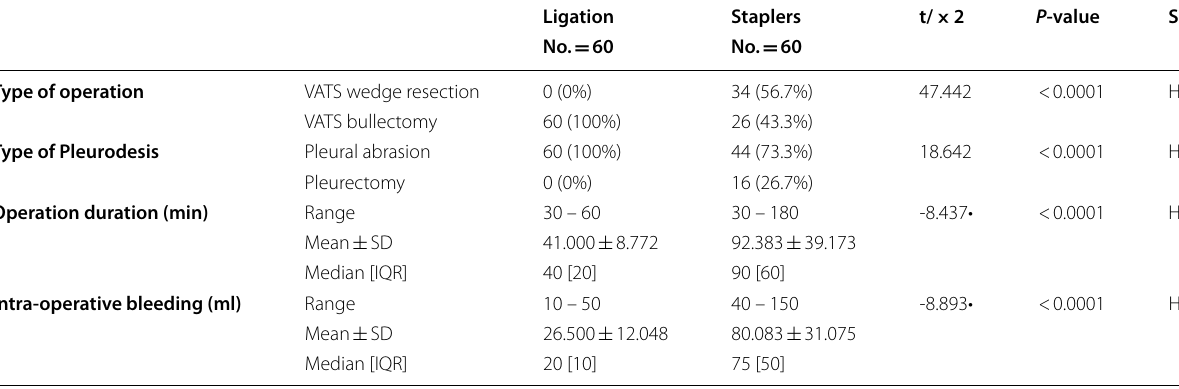
P -value > 0.05: Non-significant; P -value < 0.05: Significant; P -value < 0.01: highly significant